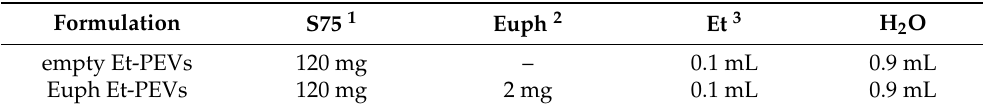
Table 5. Composition of the vesicle formulations.